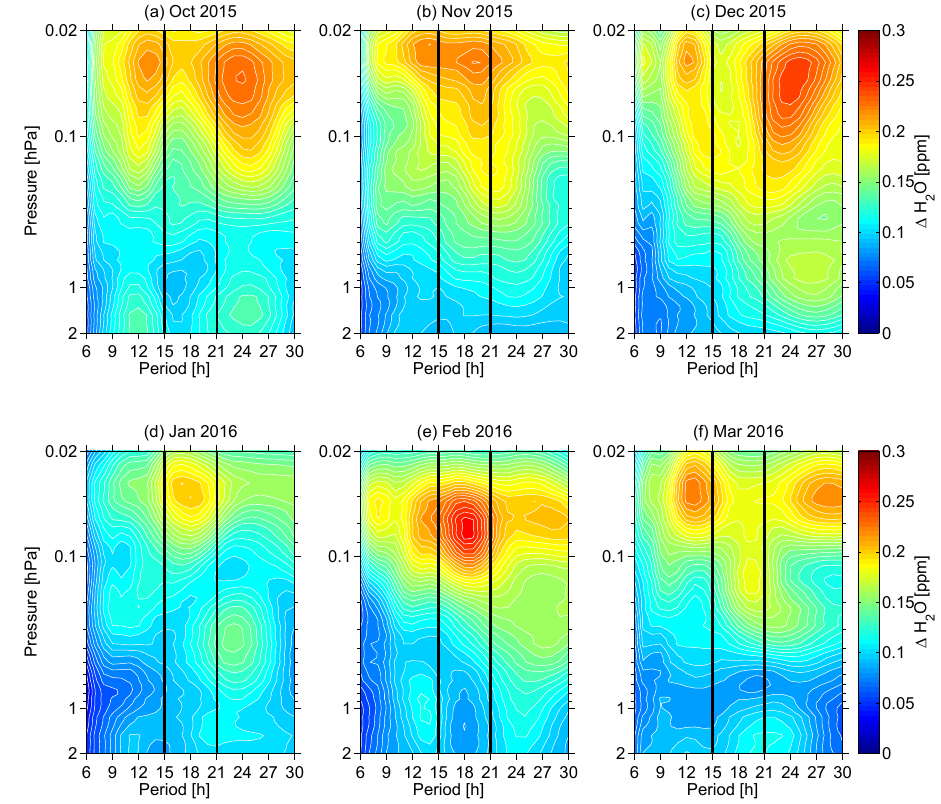
Figure 6. Same as Fig. 5 but for the months October 2015 to March 2016 (a–f)